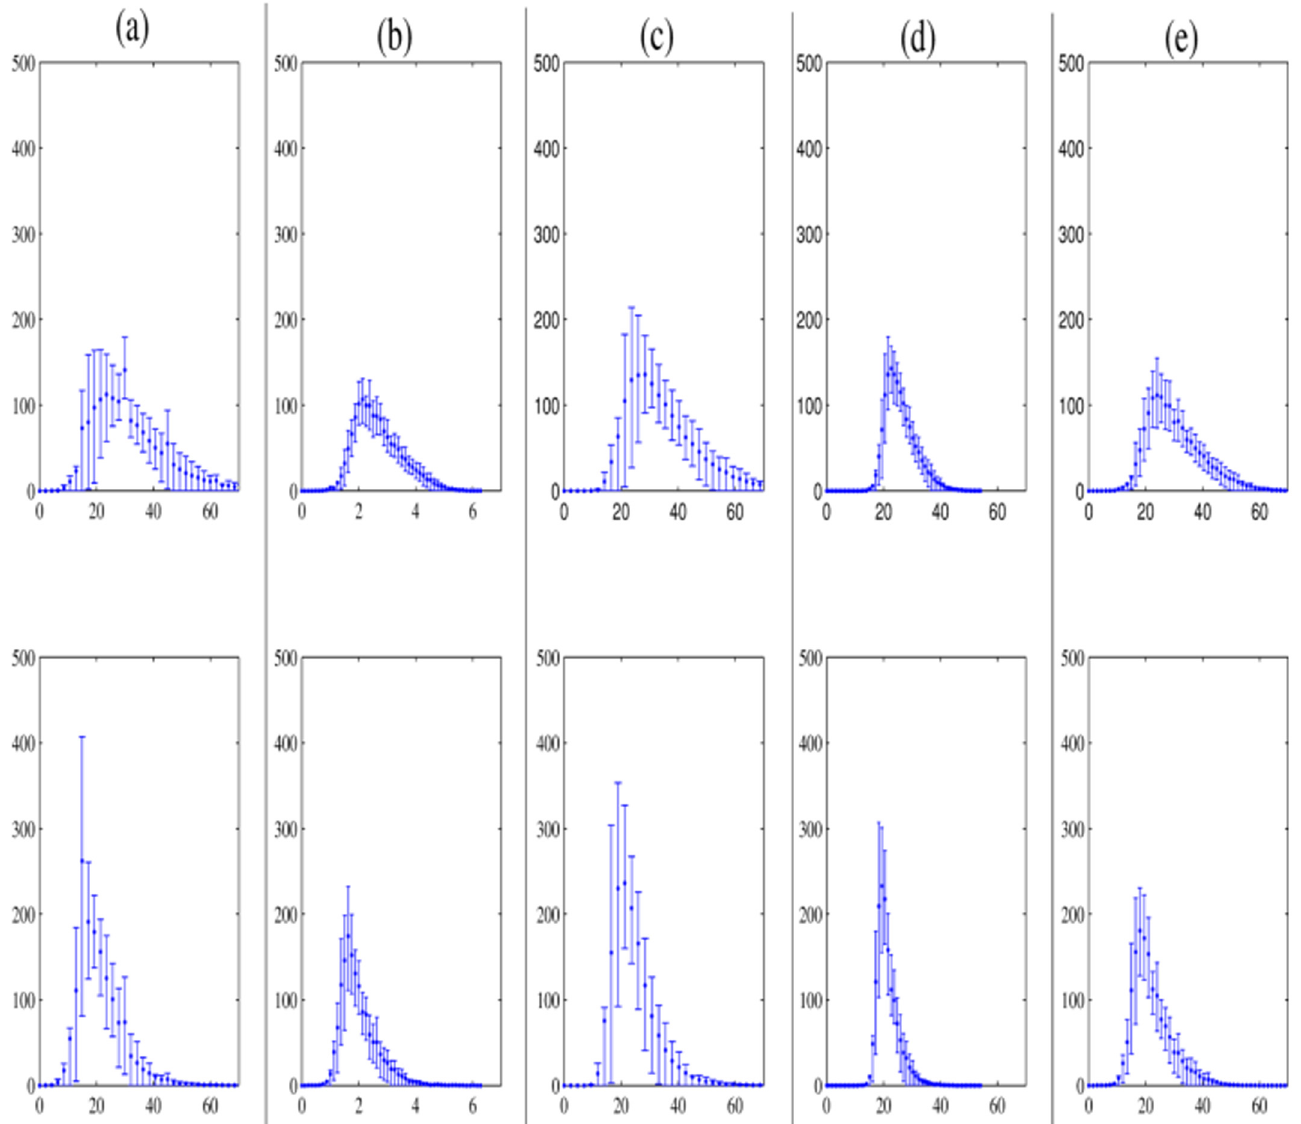
Fig 7. Mean histograms and error bars in the striatum region for 127 DaTSCAN images before and after intensity normalization, keeping separate distributions for the two different classes. The first row is for NC subjects and the second row is for PS subjects. (a): Original DaTSCAN images, (b): BR all images, (c): Filtered GMM images, (d): MSE images and (e) α stable images. The x-axis represents the intensity. The y-axis indicates the number of voxels with a given level in the striatum